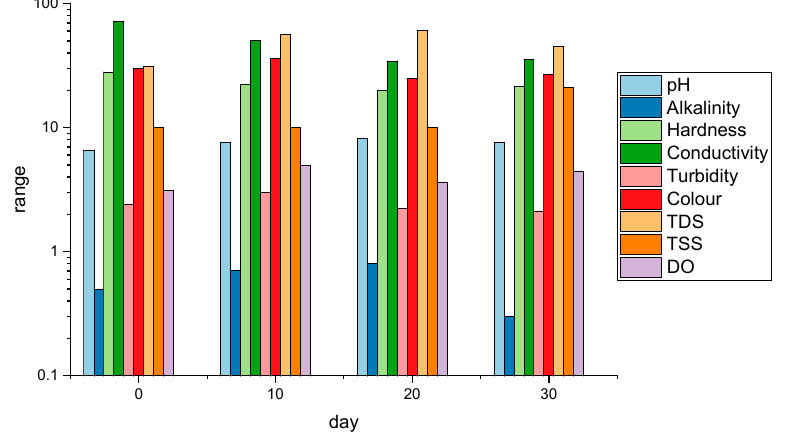
Figure 9. Physicochemical indicators of rainwater (immediately after rainfall and 10, 20, 30 days later) used in the study.